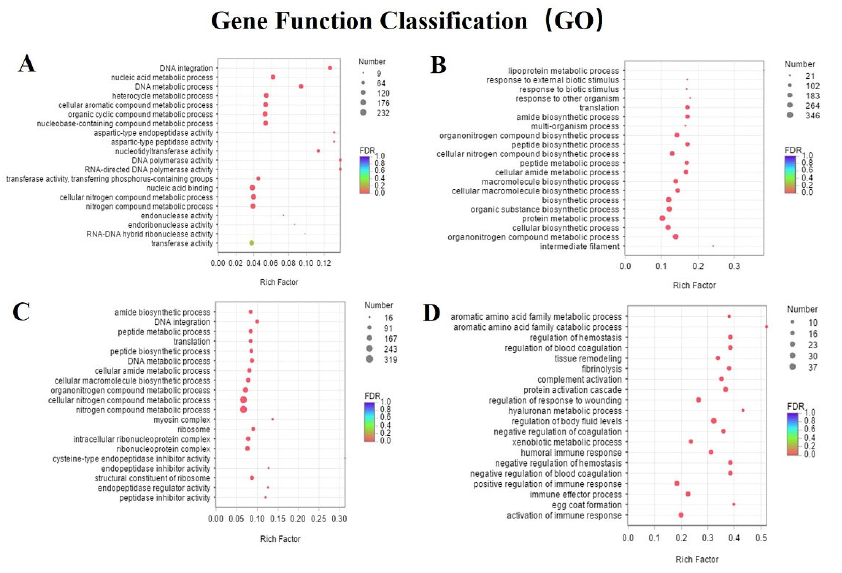
Figure 7. Bubble diagram of predicted functions encoded of hybrid triploid loaches by DEGs at ( A )